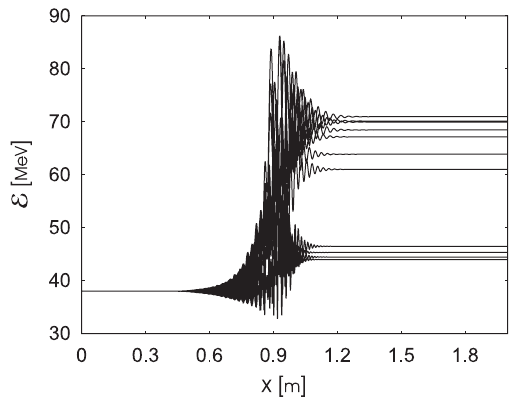
FIG. 4. The same dependence as in Fig. 3 when the particles initially situated at the different distances from the undulator axis: z 0 ¼ w 0 = 4 ( y 0 ¼ 0 ).